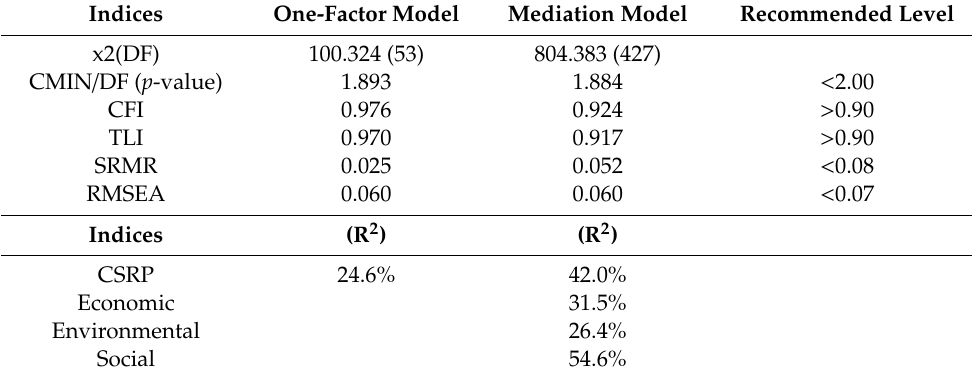
Table 7. Model fitness and R 2